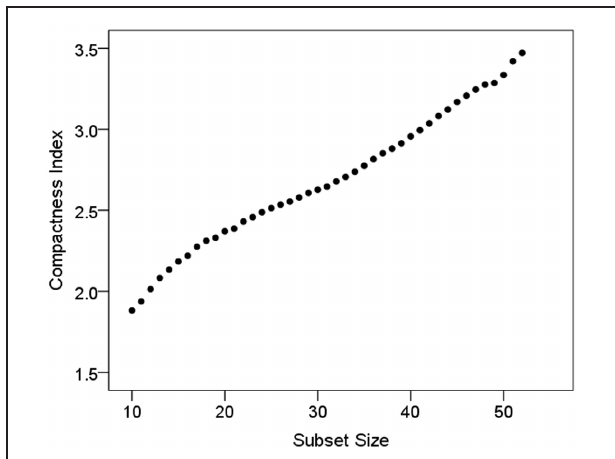
FIGURE 4 | Compactness index is plotted against subset size (see text for